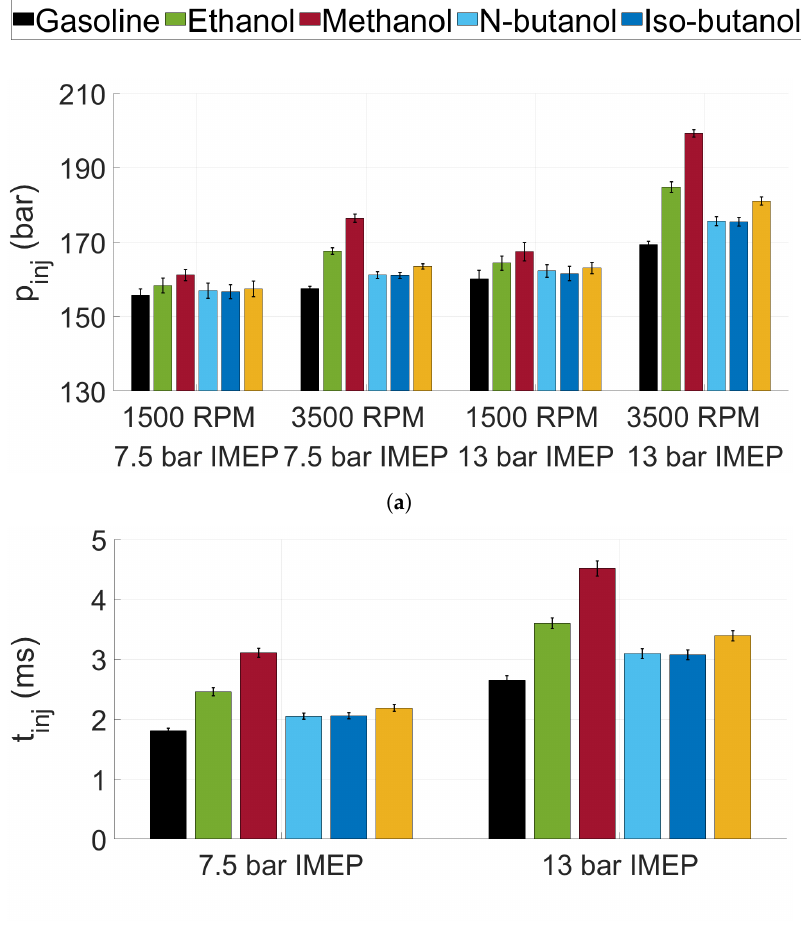
Figure 3. The injection parameters for all tested fuels at different operating points: ( a ) injection pressure and ( b ) injection duration. The error bars show the standard deviation ( ± σ